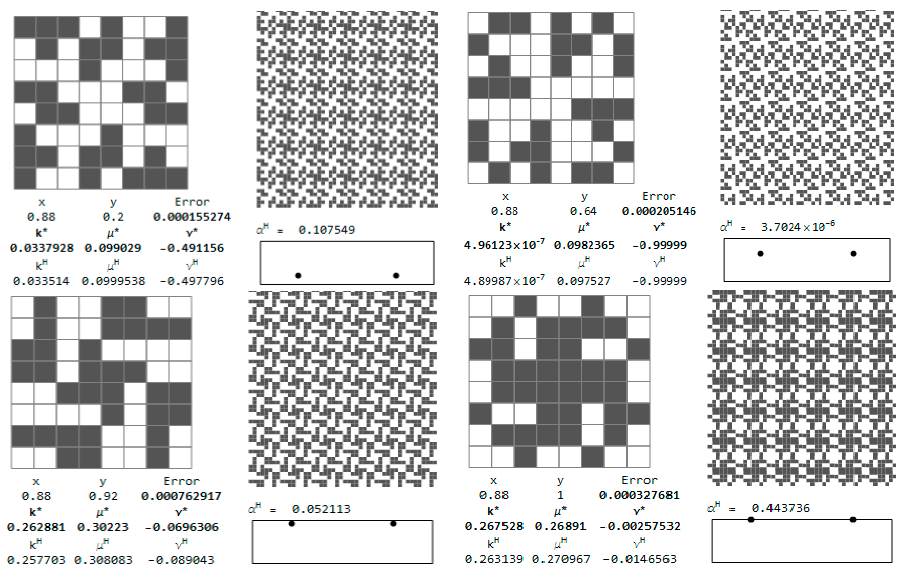
Figure 18. Optimal cubic microstructures approximating the CMD results with the error (Equation (27)) less than 0.001.